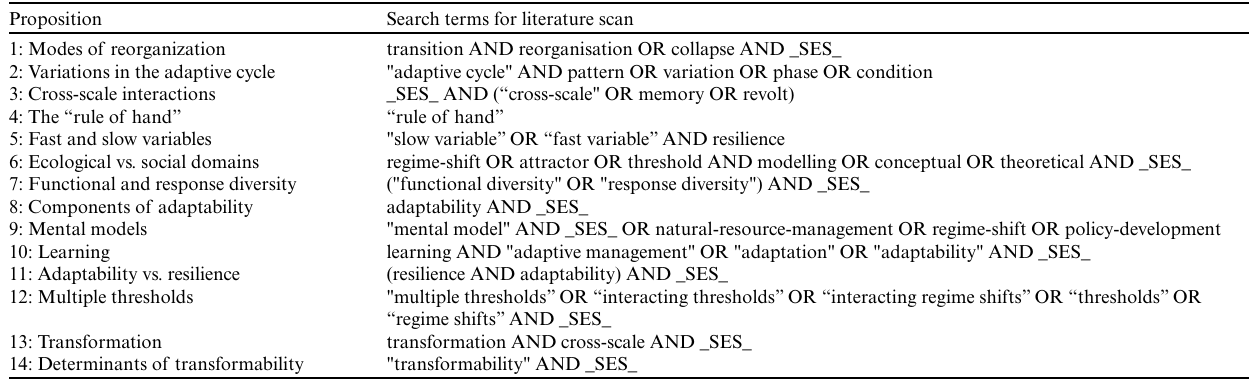
Table 2. Search terms for the literature scan. We applied each search term to the “Article title, abstract, keywords” field in Scopus. We limited the search results to the years 2006-2019. The search terms were adapted for each proposition. Additionally, in each search, (_SES_) was replaced by ("social-ecological system" OR "socio-ecological system" OR "human-environment system" OR "human and natural system" OR "socio-environmental